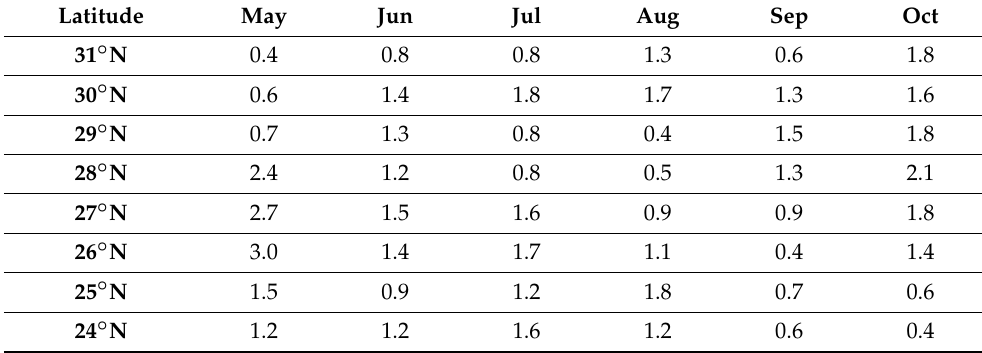
Table 4. Offshore SST—Minimum SST ( ◦ C) during warm seasons.